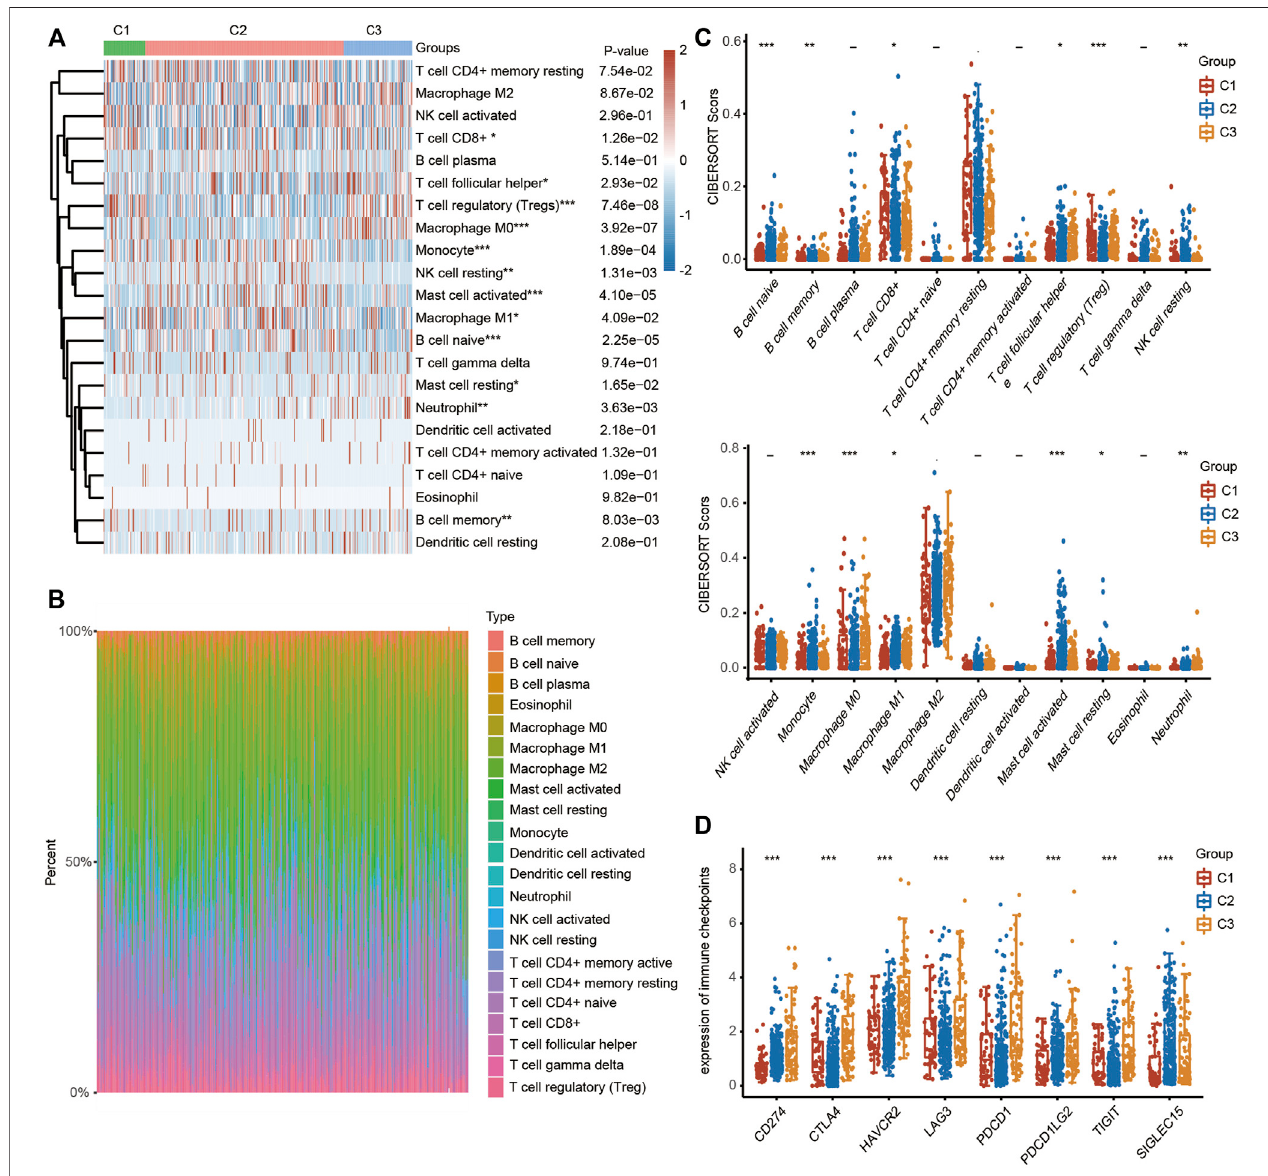
FIGURE 4 | TME characteristics in three different HCC clusters. (FRGs in three clusters are positively correlated with immune cell in fi ltration in HCC). (A) Heatmap showing the different in fi ltration levels of immune cells in the three clusters. (B) Bar plot showing the composition of different immune cells in each patient from the three clusters analyzed by CIBERSORT. (C) Violin plots showing the different in fi ltration levels of immune cells in the three clusters. The difference in three clusters was compared statistically with the Kruskal – Wallis test. (D) Violin plots showing the different expression levels of immune checkpoint genes in the three clusters. The difference in gene expression was compared statistically with the Kruskal – Wallis test. The interquartile range of values is represented by the upper and lower ends in the box and the median value is represented by the lines in the boxes. The outliers are shown as dots. * p < 0.05, ** p < 0.01, *** p <